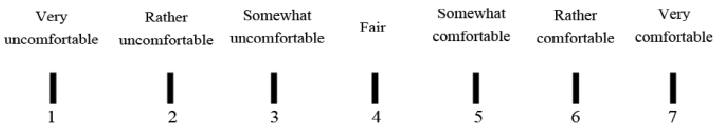
Figure 1. Evaluation criteria of the Likert scale.